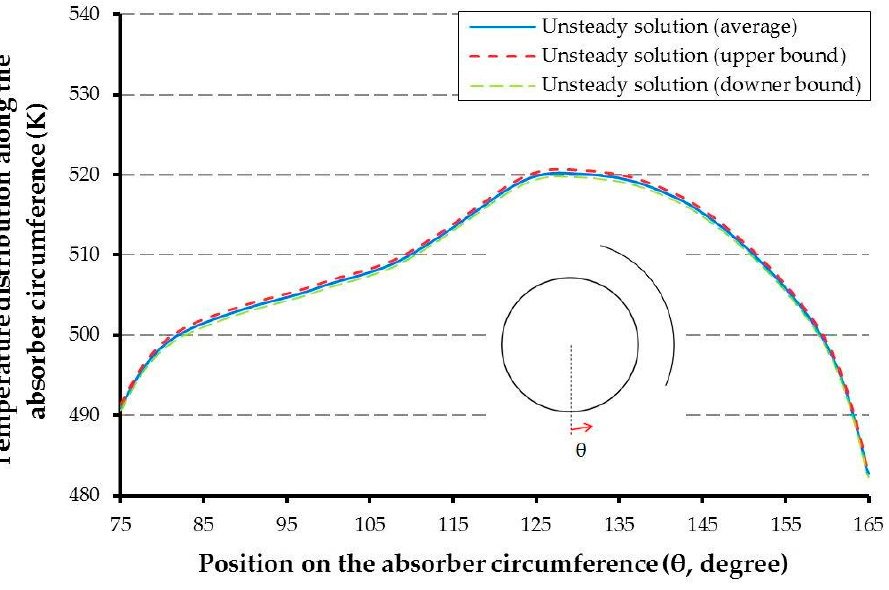
Figure 9. Temperature distribution along the outer surface of the absorber while heat flux on the kiln is constant.